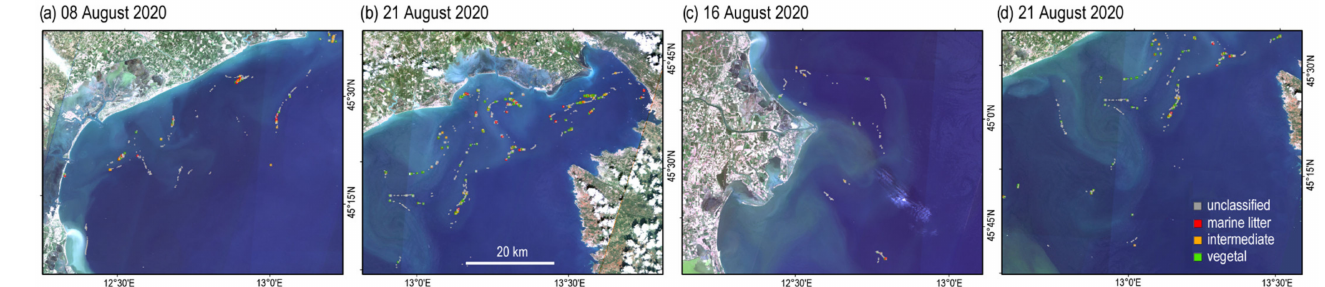
Figure 9. Most relevant distributions of floating matter in August 2020 in different areas of North Adriatic.